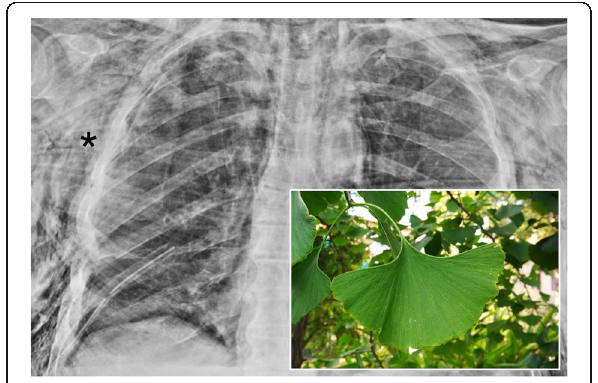
Fig. 16 Ginkgo leaf sign. A chest radiograph of a patient with diffuse subcutaneous emphysema. The post-surgical radiograph clearly shows a large amount of air located in the subcutaneous tissues, penetrating into the pectoral muscle fibers (black